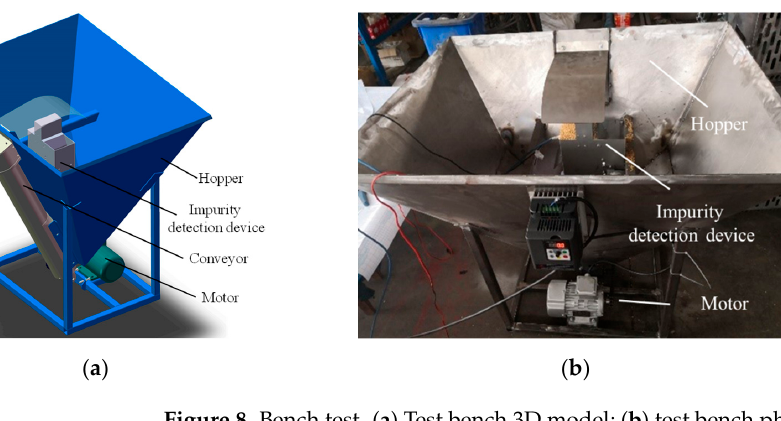
Figure 8. Bench test. ( a ) Test bench 3D model; ( b ) test bench physical picture; ( c ) material collection.